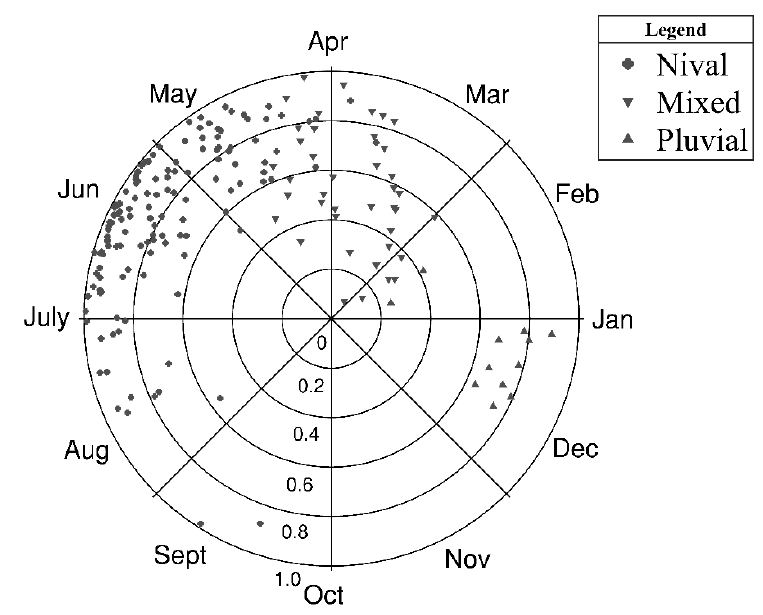
Figure 3. The 186 study sites plotted in flood seasonality space.